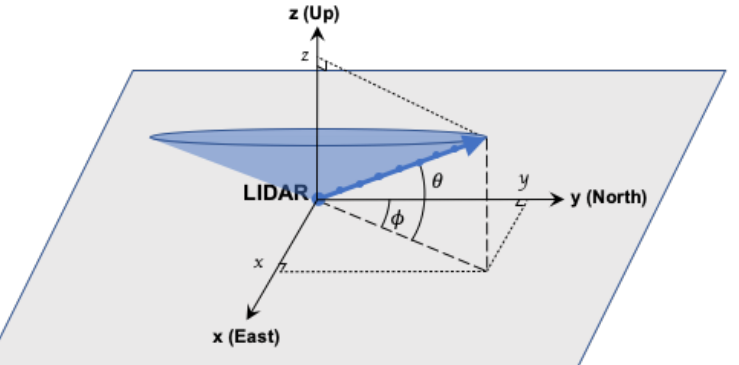
Figure 1. Representation of a PPI scan. The figure also displays the wind analysis spherical system (defined by the azimuth angle φ and the elevation angle θ ) along with the Cartesian coordinate system (defined by the coordinates x , y and z ). The blue dots along the LiDAR beam illustrate the range gates over which the radial velocities are